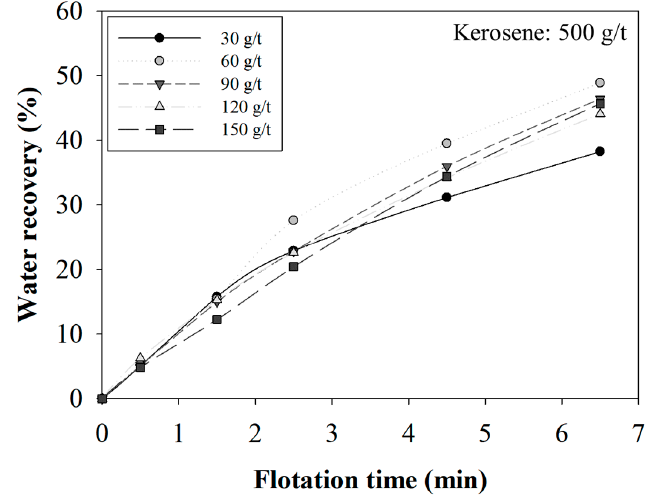
Figure 5. Water recovery changes for different MIBC dosages.